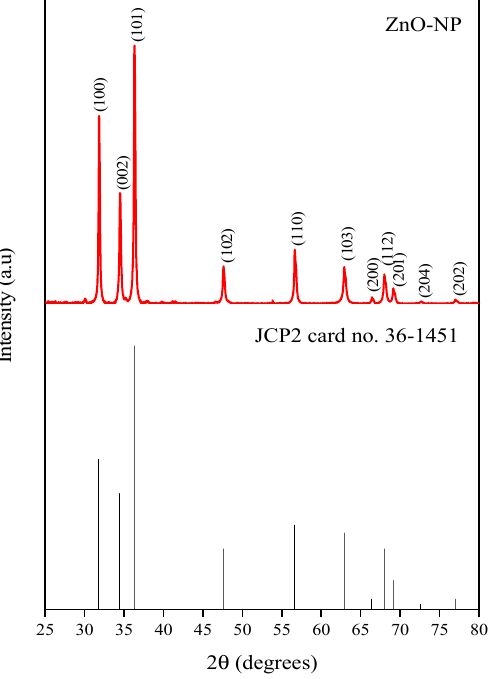
Figure 1. XRD analysis of ZnO-NPs biosynthesized using C. chinense fruit extract.